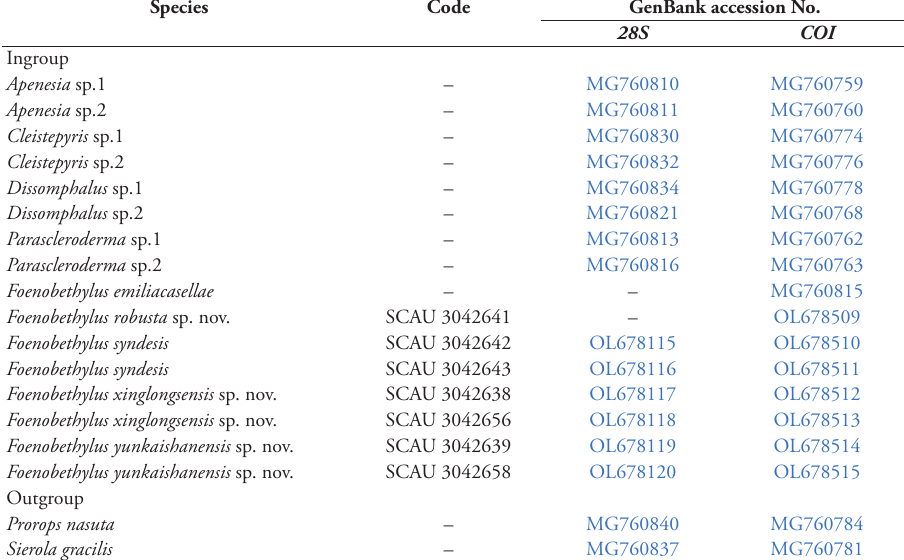
Table 1. List of analyzed taxa and accession numbers. Species Code GenBank accession No.